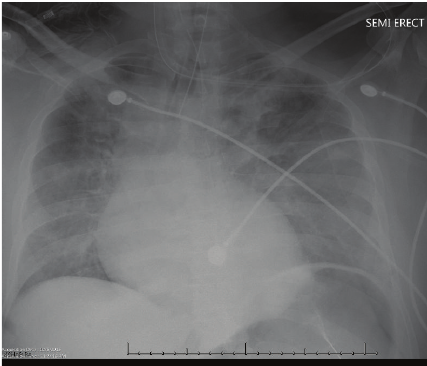
Figure 1: Chest radiograph shows endotracheal tube in position.